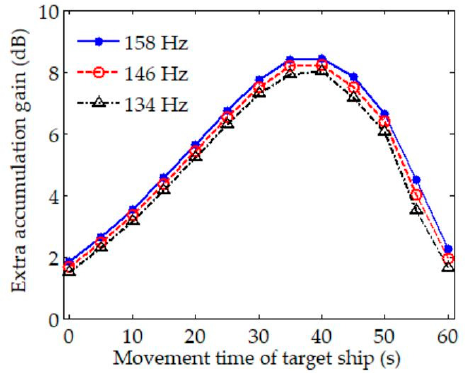
Figure 7. Extra integration gain provided by CCPSCI compared with CPSII in simulation.